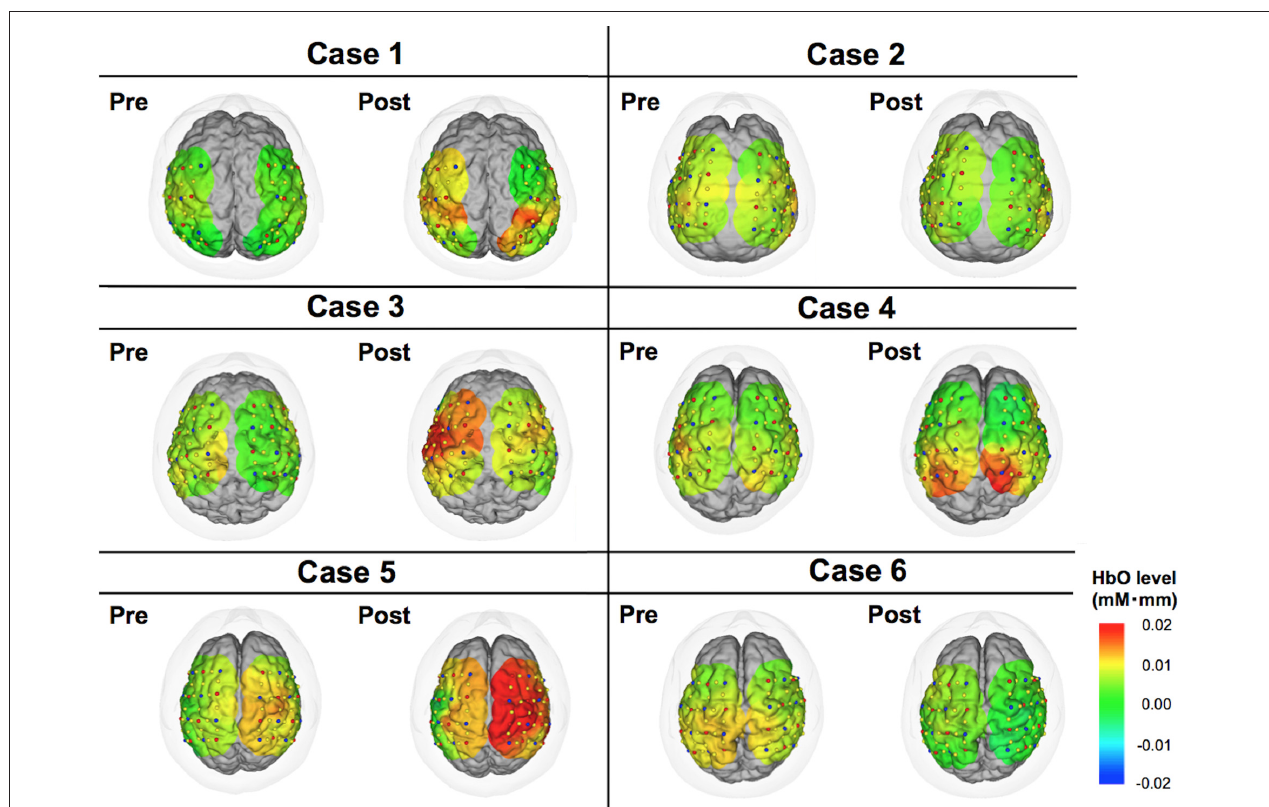
FIGURE 3 | Color maps of HbO levels comparing pre- vs. post-DBS states. These images indicate cortical activities at 15 s from the start of motor task. Relative changes compared to the status at 0 s are demonstrated in this figure.